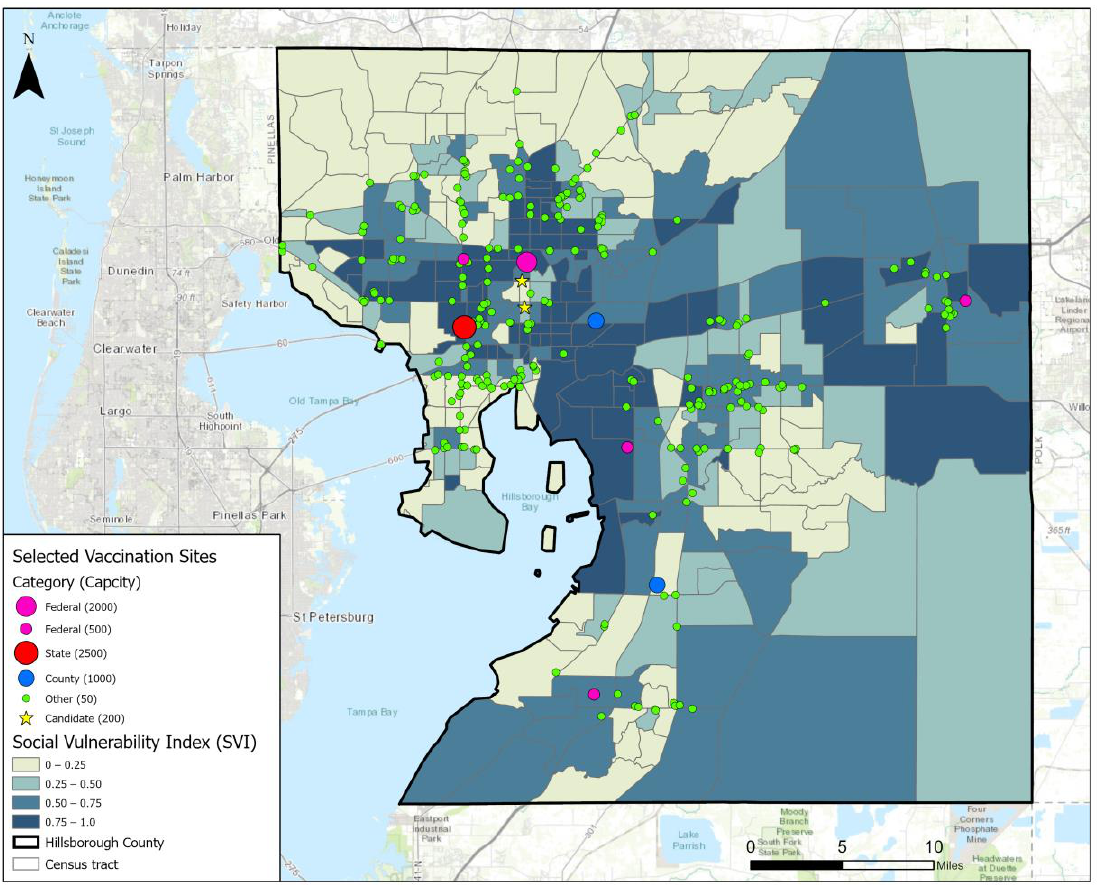
Figure 5. An example of practical solution by involving constraints C and